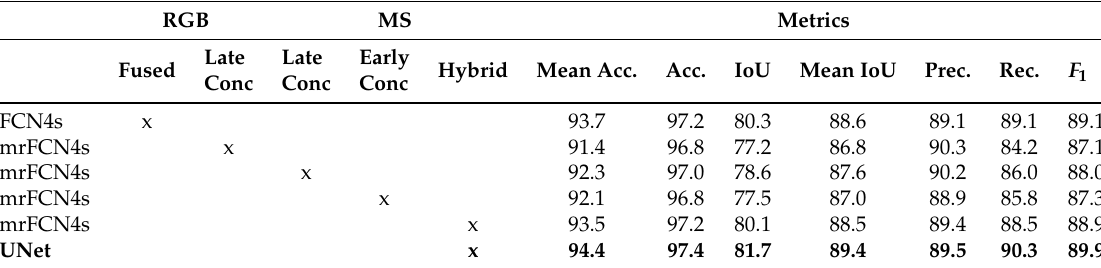
Table 4. Quantitative results of the examined architectures, given in percent. The superior values are highlighted in bold.